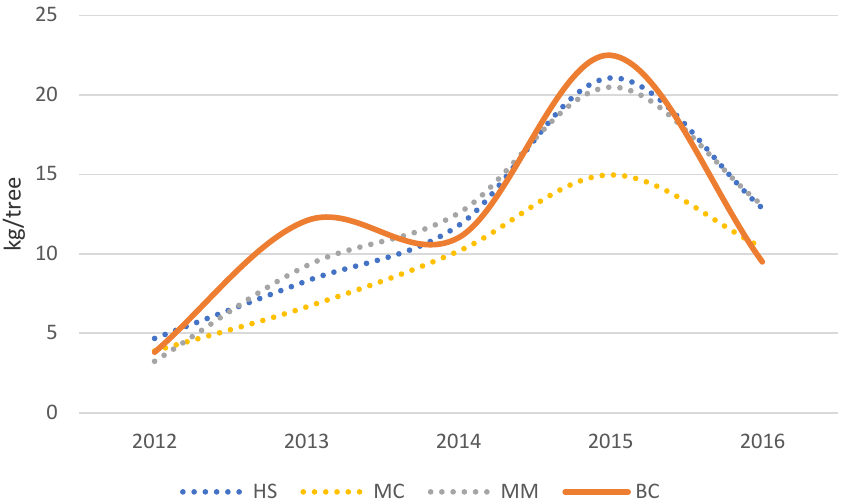
Figure 3. Biennial bearing index of Gold Chief/M.9 with different floor management systems during 2012–2016. HS: Herbicide strip; MC: Mechanical cultivation; MM: Miscanthus spp . mulch; BC: Black polypropylene woven ground cover.